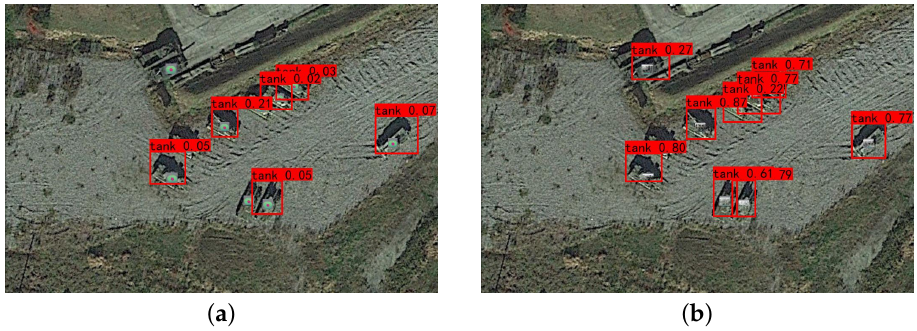
Figure 11. ( a ) detection results of adversarial patch using Gaussian blur with a radius of 1 pixel under YOLOv3; ( b ) the detection result of the ( a ) after our defense algorithm.